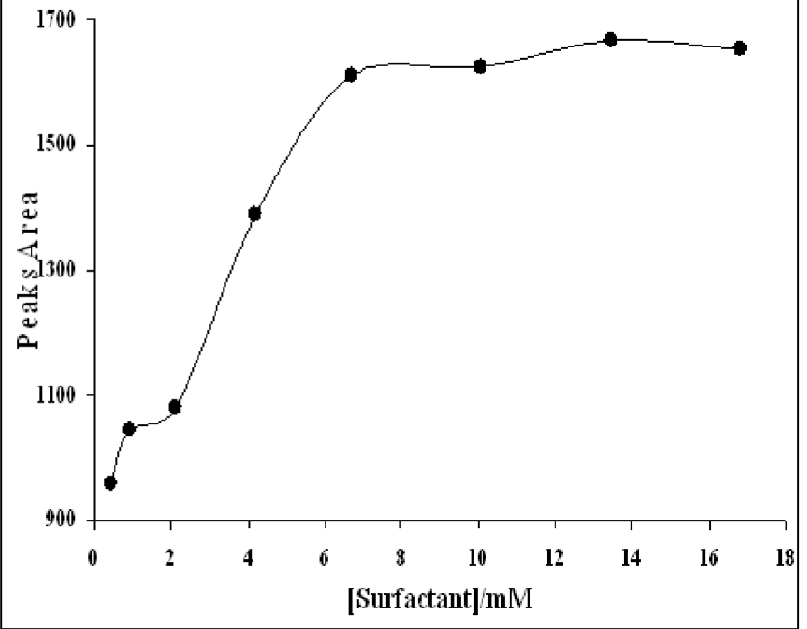
Figure 2. Total extracted phenolic compounds versus surfactant concentration.